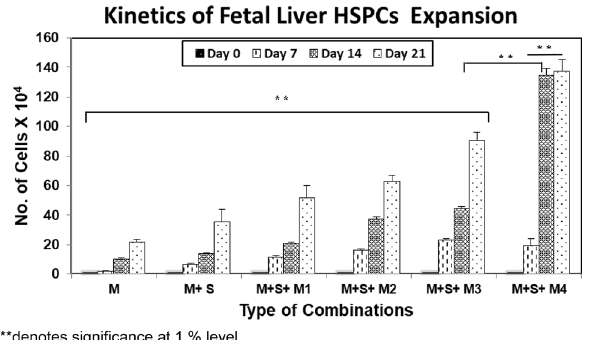
Figure 2. Kinetics of fetal liver CD34 + HSPCs expansion Estimated cell counts at 7-days intervals from day 0–24. Expansion of total cells expressed as fold increase over initial cell input in all the tested combinations. Results are expressed as mean ± SEM of 5 experiments. Statistical significance was analyzed via ANOVA and is depicted with asterisks (*). double (**) asterisks indicate P ≤ 0.01. The increase in number of cells in different combinations (M vs M + S + M3 and M3 vs M4) as well as at different days (day 7 vs Da 21) in M + S = M4 shows significant increase with P ≤